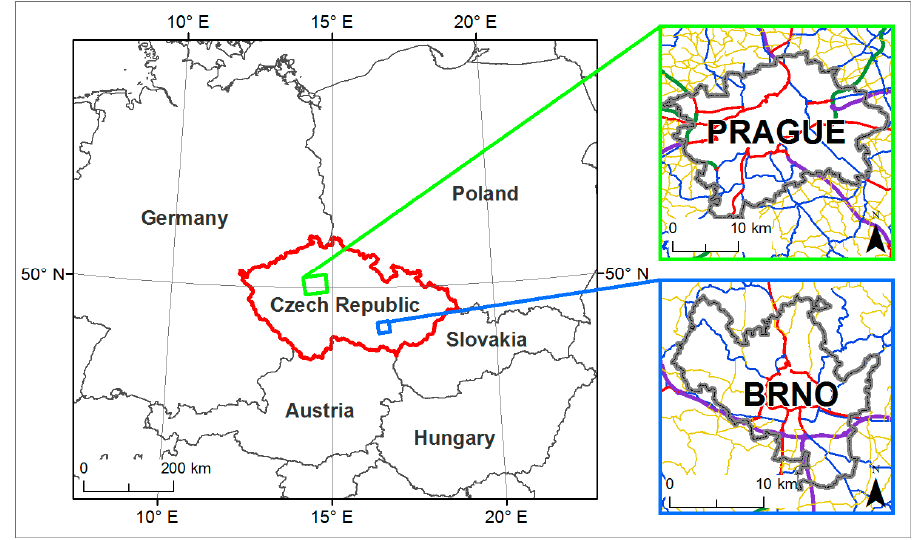
Figure 1. Locations of Brno and Prague within central Europe and demarcation of the study areas with cadastral borders of compact urban development. Table 1. Basic data, study areas.